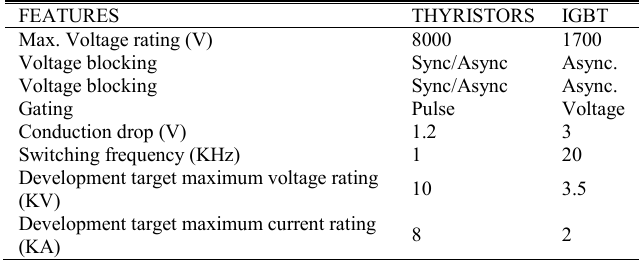
TABLE IV A C OMPARISON OF T HYRISTOR AND IGBT